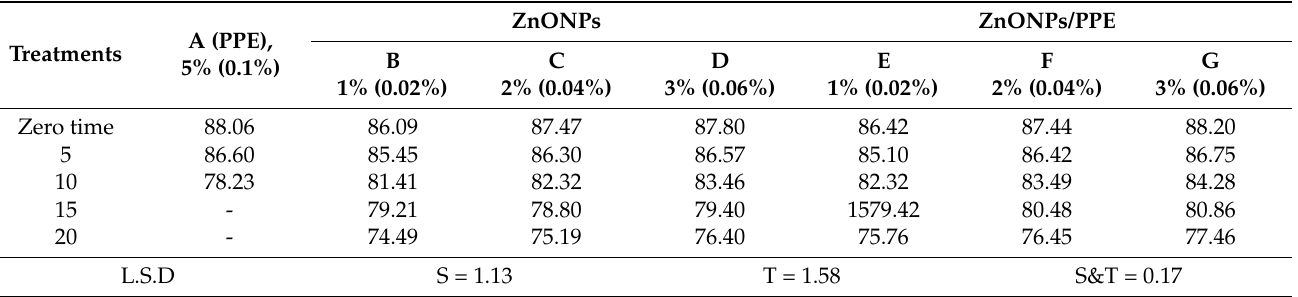
Table 13. Effect of edible film and coatings on color [hue angle ( h ◦ )] t of manfalouty pomegranate during storage at 2 ◦